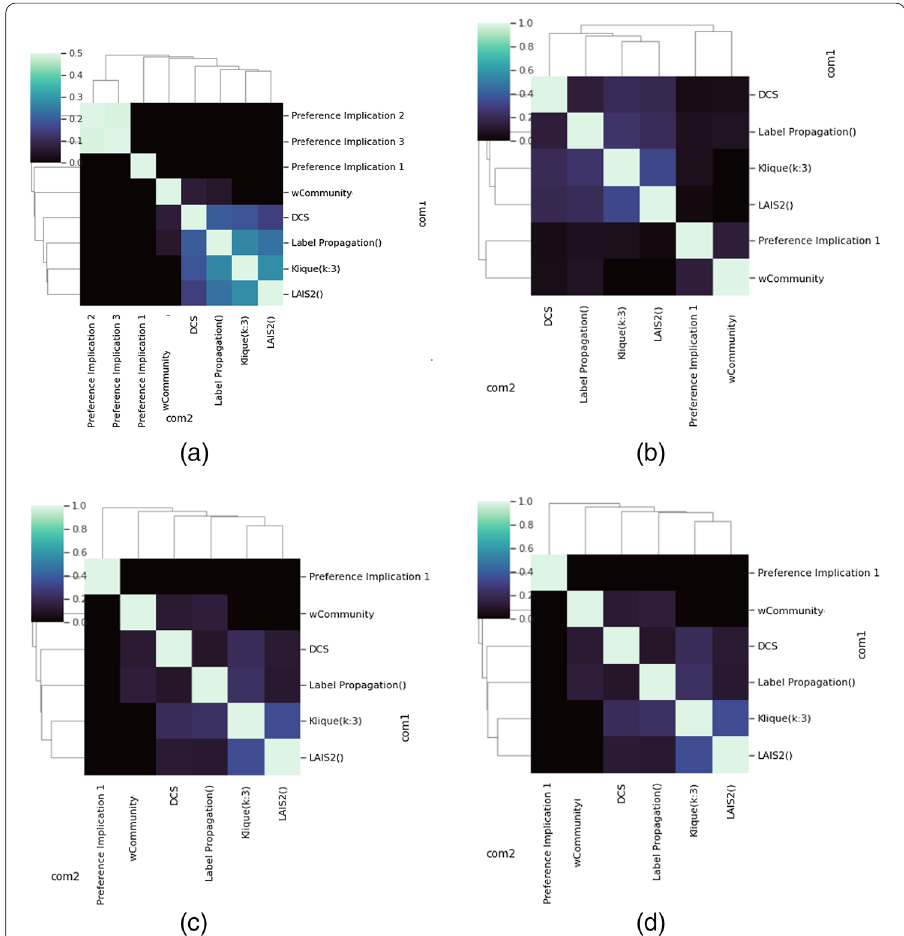
Fig. 14 The figure above is the NMI similarity matrix of the preference-value based method for four artificial weighted networks. The preference-based method with a value of ν = 0.65 and α = 0.75 is compared with other existing algorithms using an NMI similarity matrix. We plot the results for networks of sizes a 1000, b 2000, c 3000, d 6000